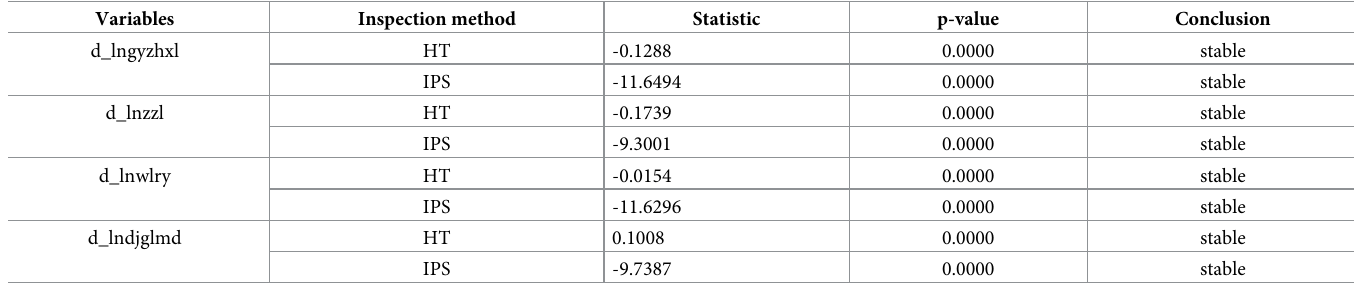
Table 5. Unit root test results of variables first-order difference